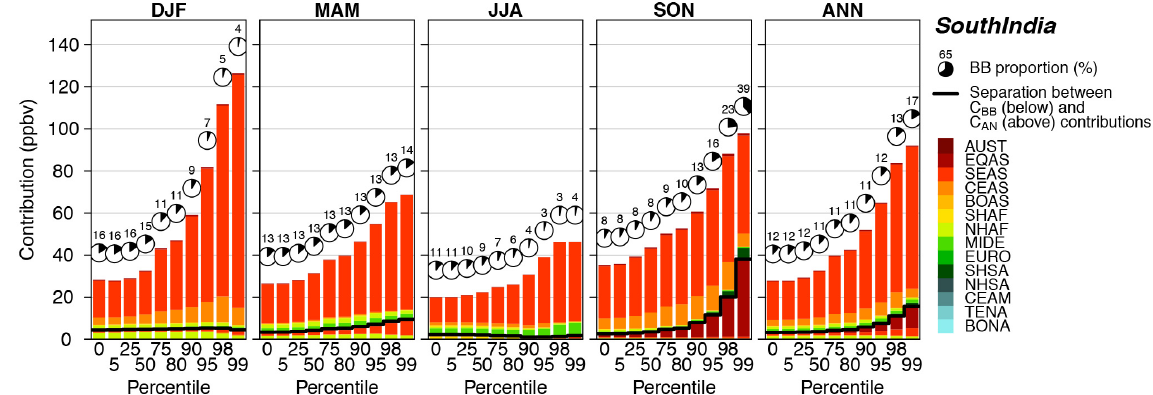
Figure 21. Same as Fig. 16 for the SouthIndia